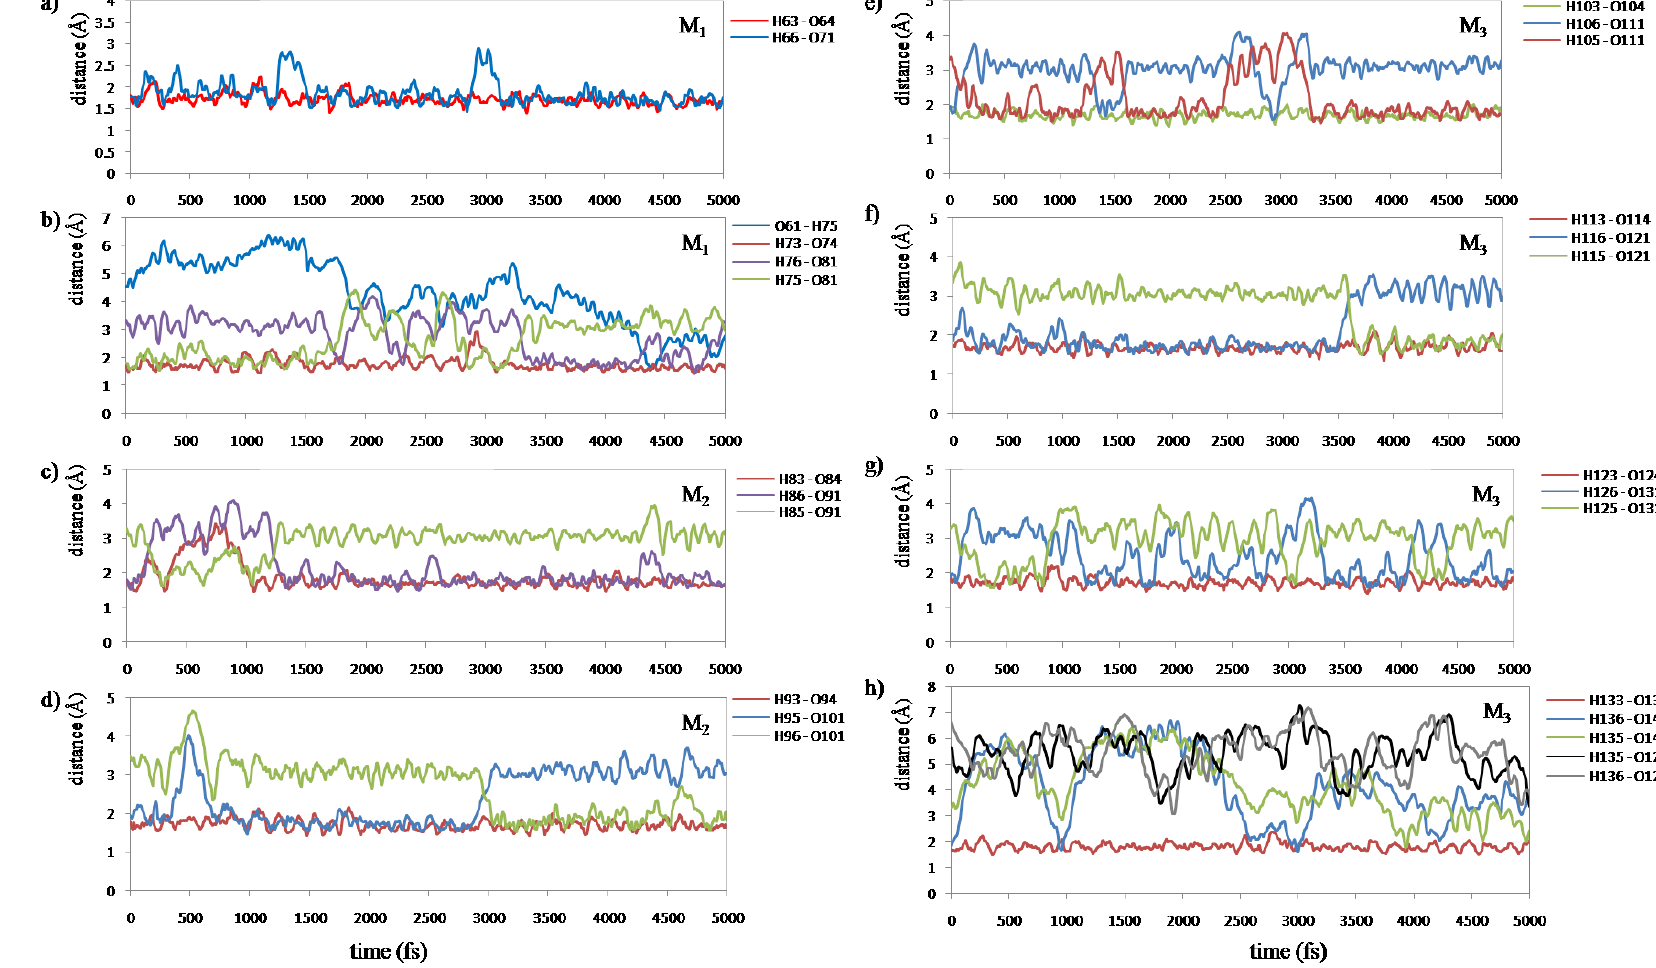
, M and M denote the M region, M region and M region shown in Figure 5 respectively. 1 2 3 1 2 3